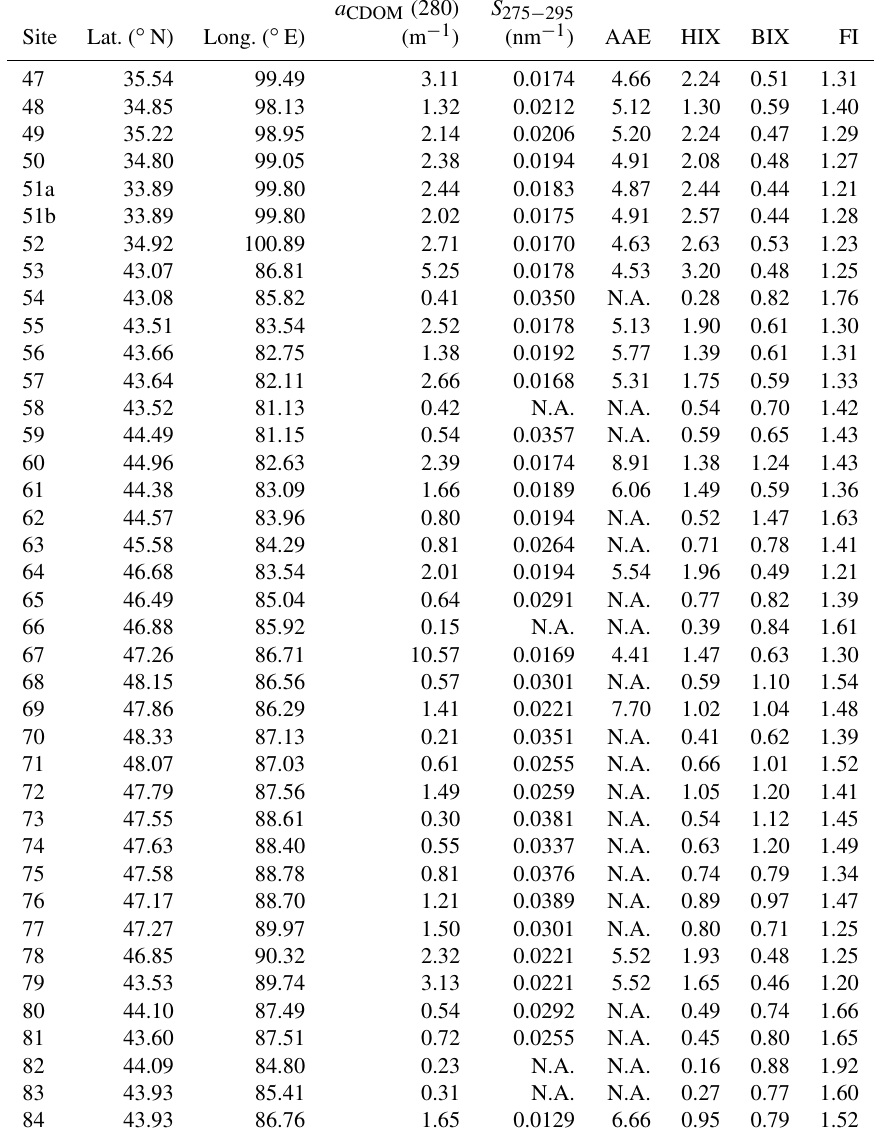
Table 1. Statistics on absorption and fluorescence parameters for snow CDOM at each site. Note that N.A. stands for no